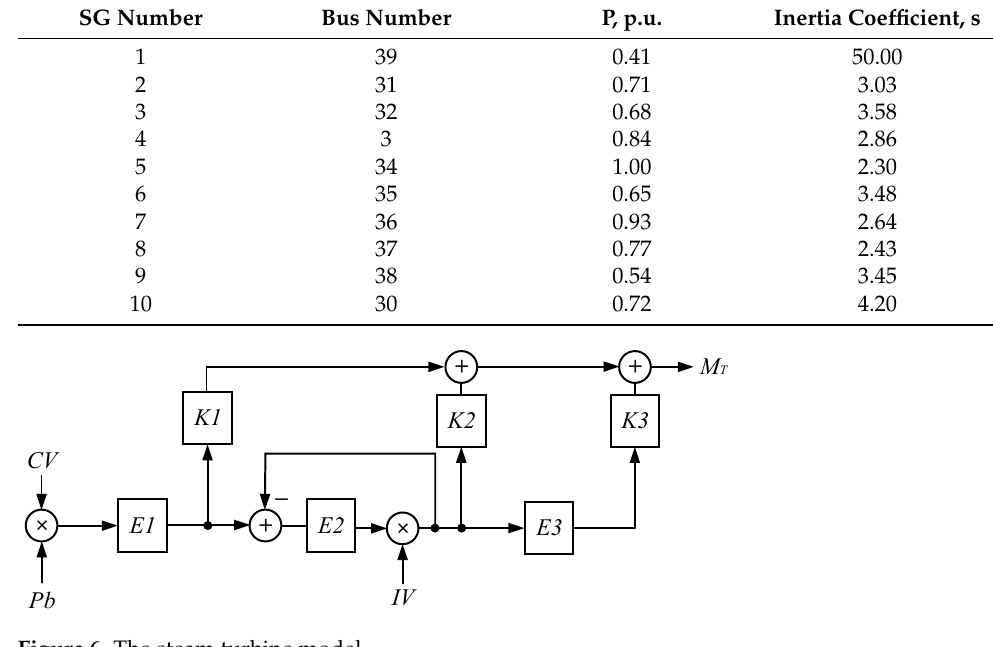
Figure 6. The steam turbine model.